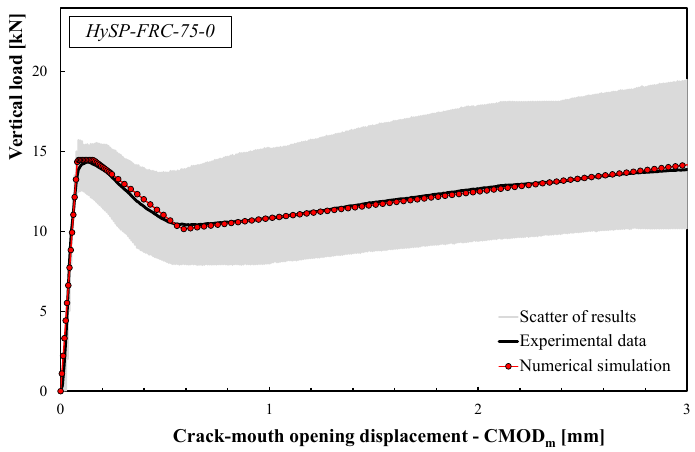
Figure 8. Experimental and numerical load–CMOD curves for the HySP-FRC-75-0 mixture.